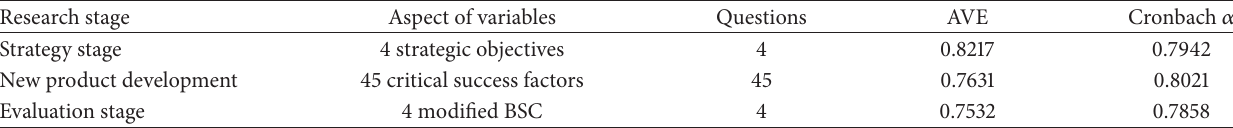
Table 2: Reliability and validity coefficients at different stages of questionnaires.